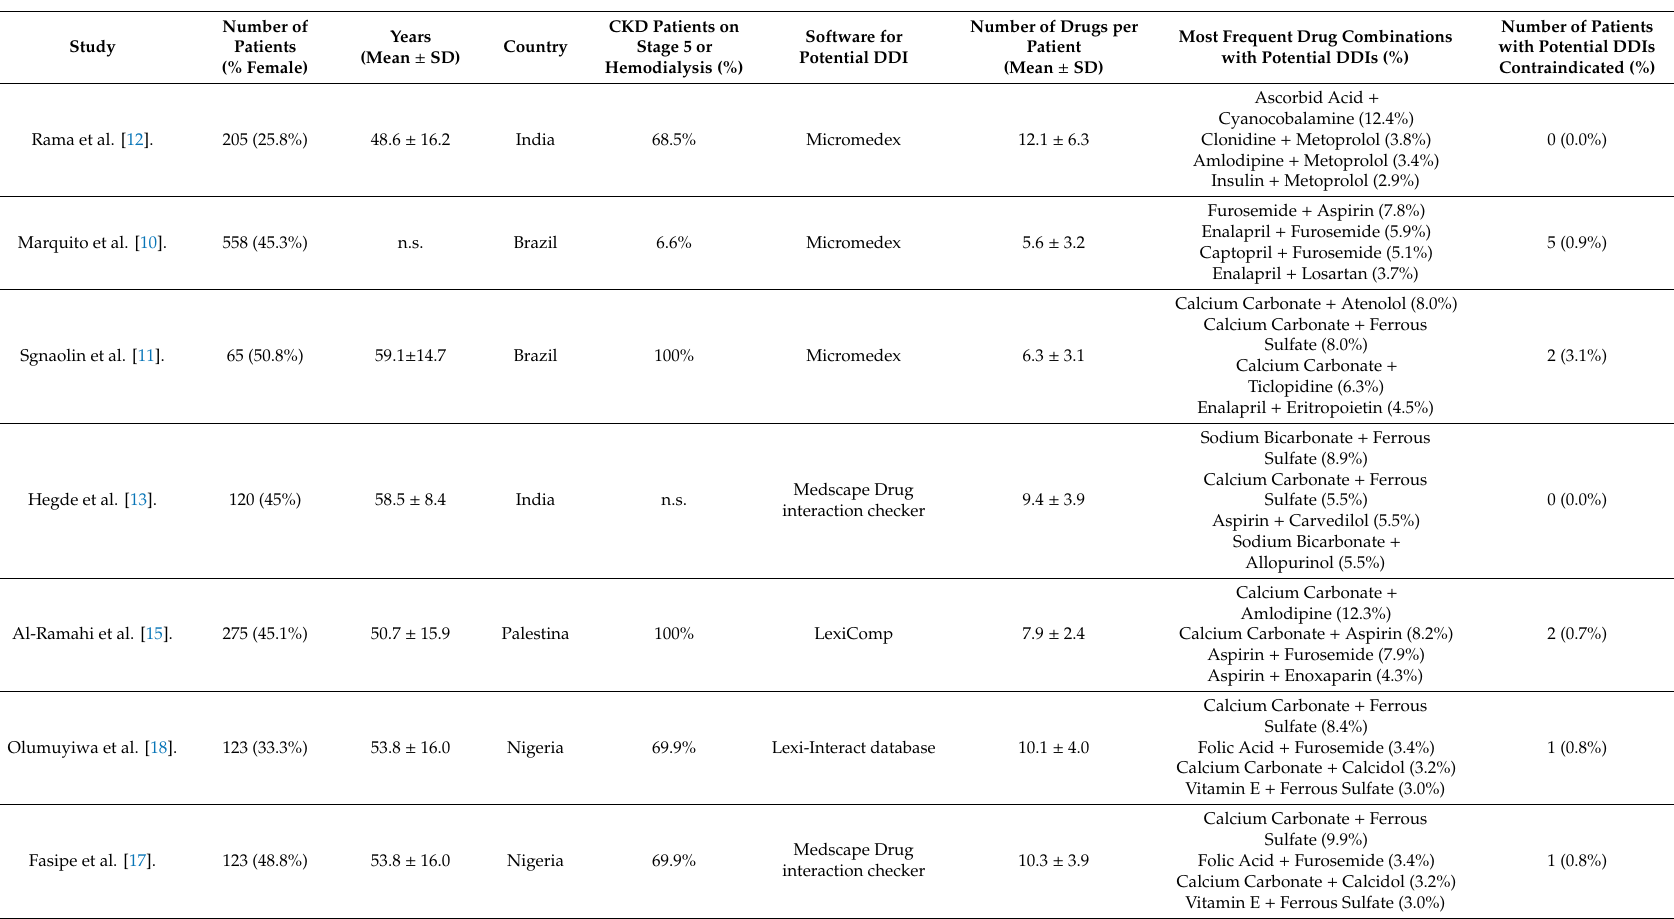
Number of Patients with Potential DDIs Contraindicated (%) 0